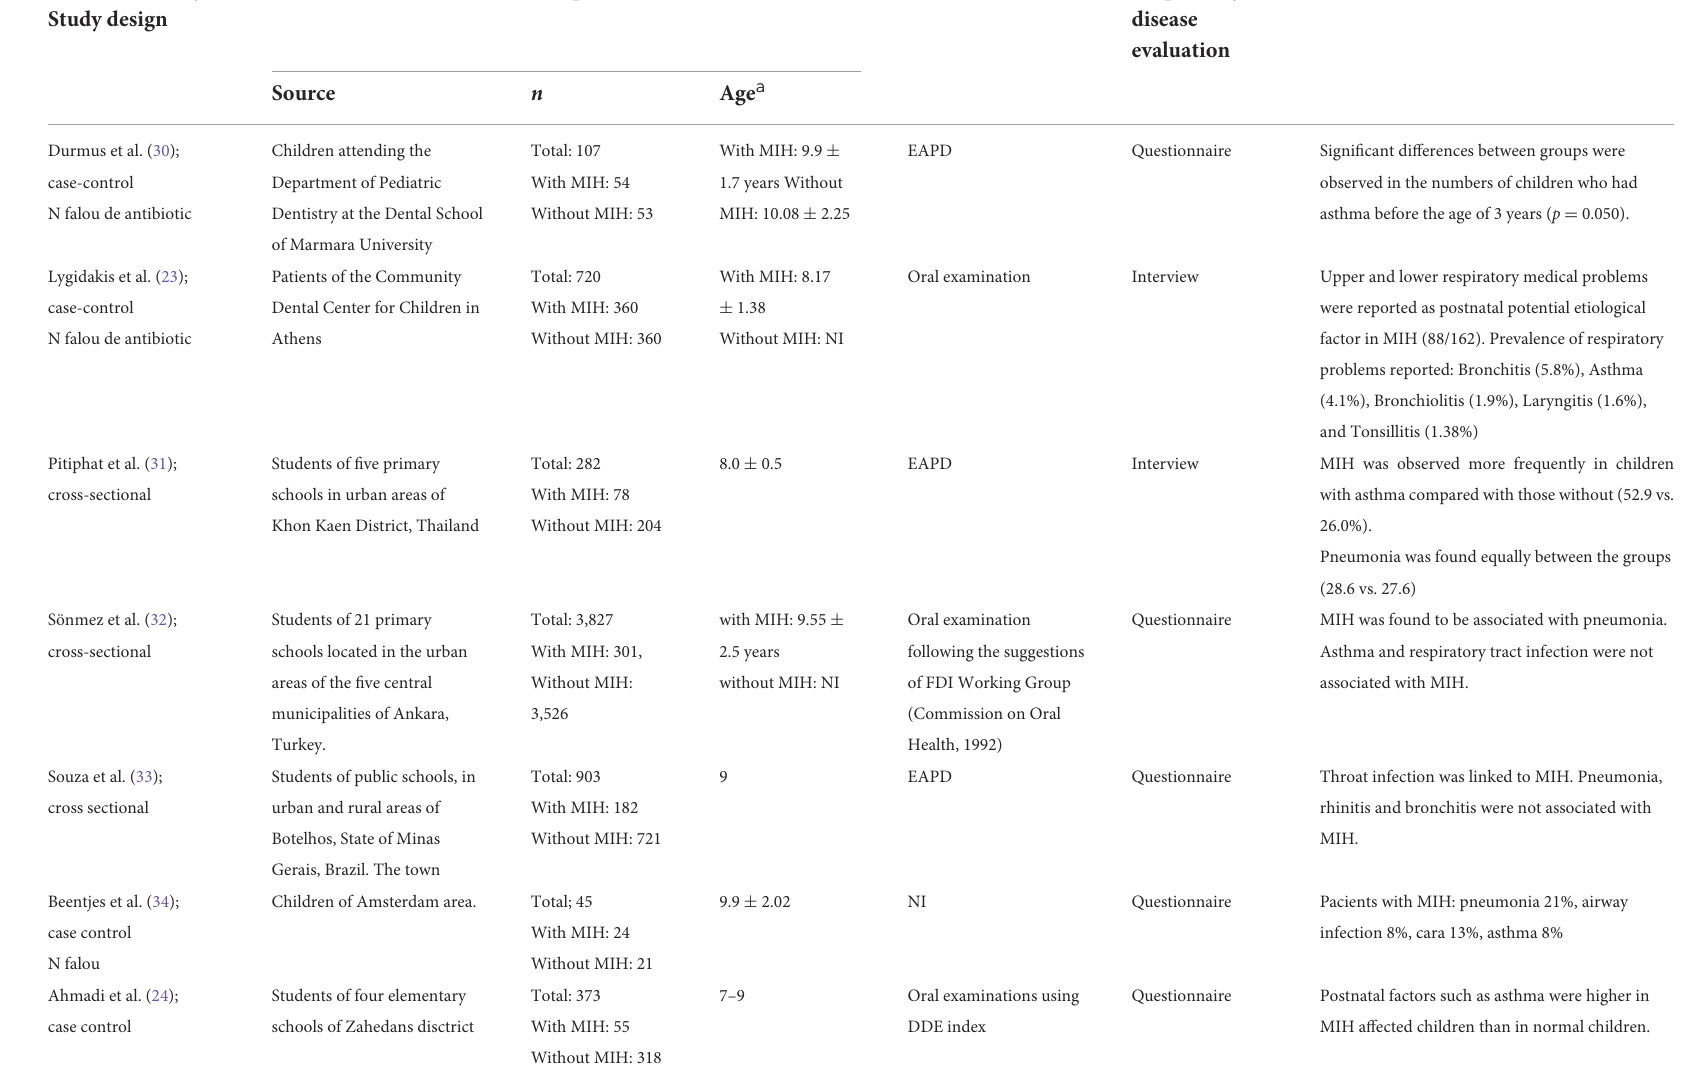
TABLE 1 Summary of characteristics and results of the included